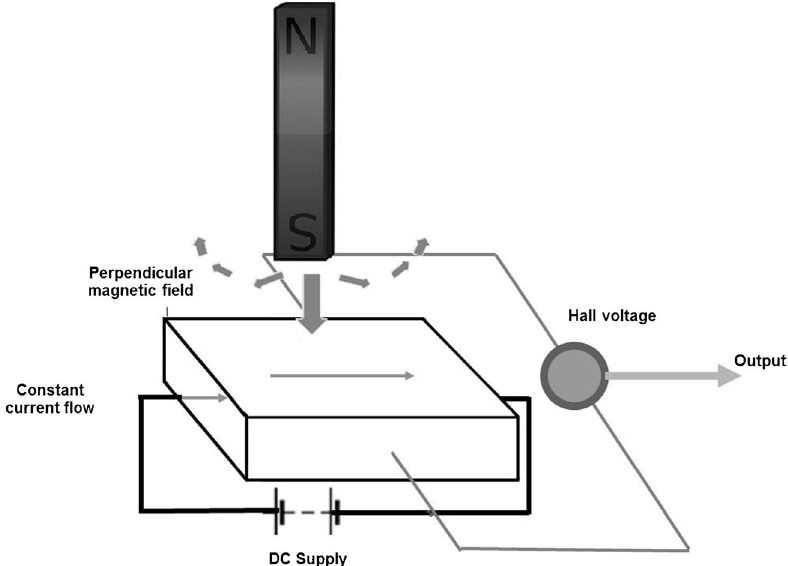
Fig. 4 A Hall sensor varies its output voltage in response to